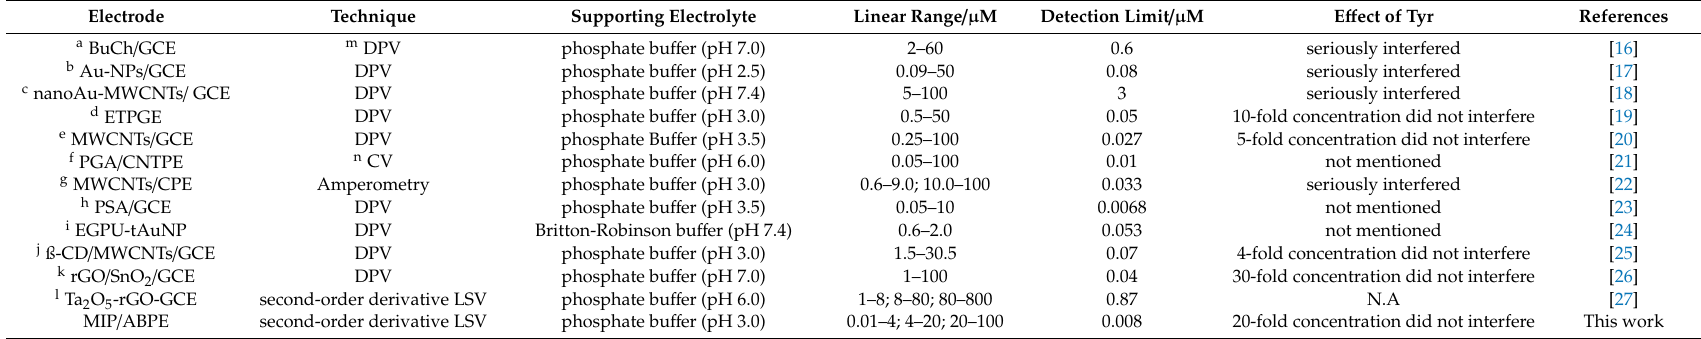
Table 1. The comparison of the e ffi ciency of molecularly imprinted polymers (MIP) / acetylene black paste electrode (ABPE) with other modified electrodes in the electrochemical determination of